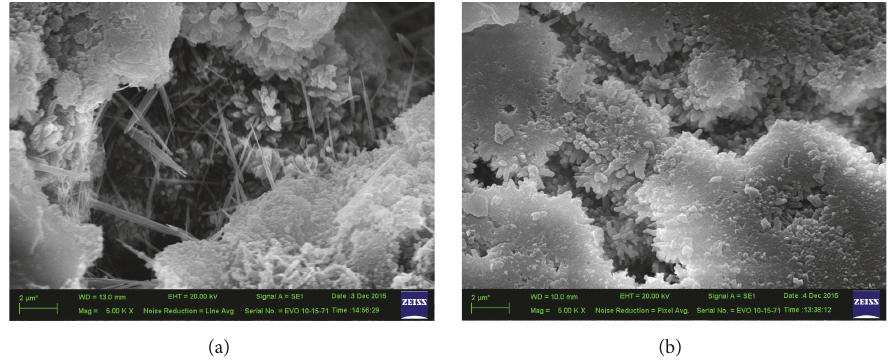
Figure 15: SEM of mortar with 2% SRA: (a) cured at 30 ∘ C; (b) steam-cured at 65 ∘ C.